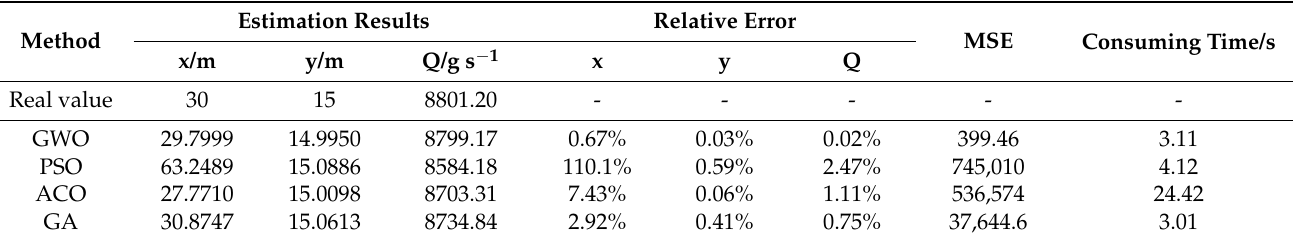
Table 1. Source estimation results of different methods for simulation case.